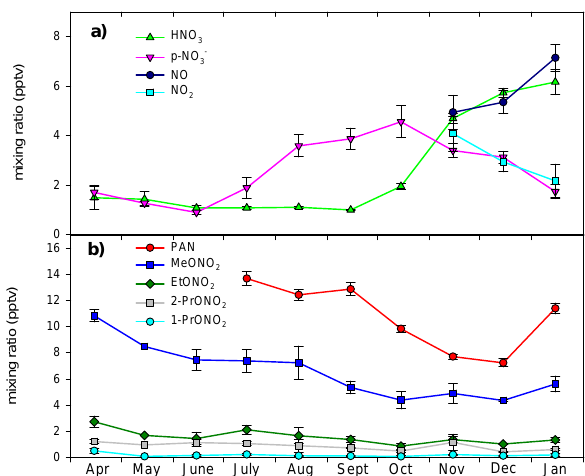
Fig. 3. Comparison of monthly-averaged NO y components (mean and standard error of the mean) during the measurement period from April 2004 to January 2005; (a) measured inorganic and aerosol components; (b) measured organic components. Note data are plotted on different